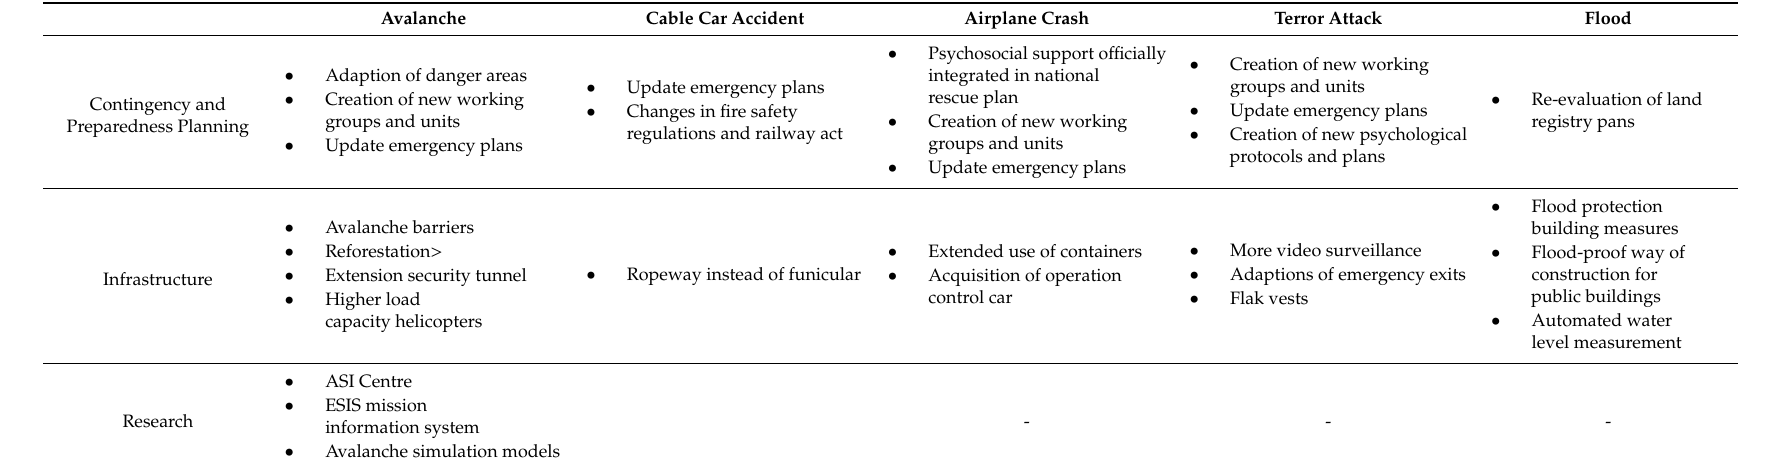
Table 3. Overview of long-term impacts on security and health